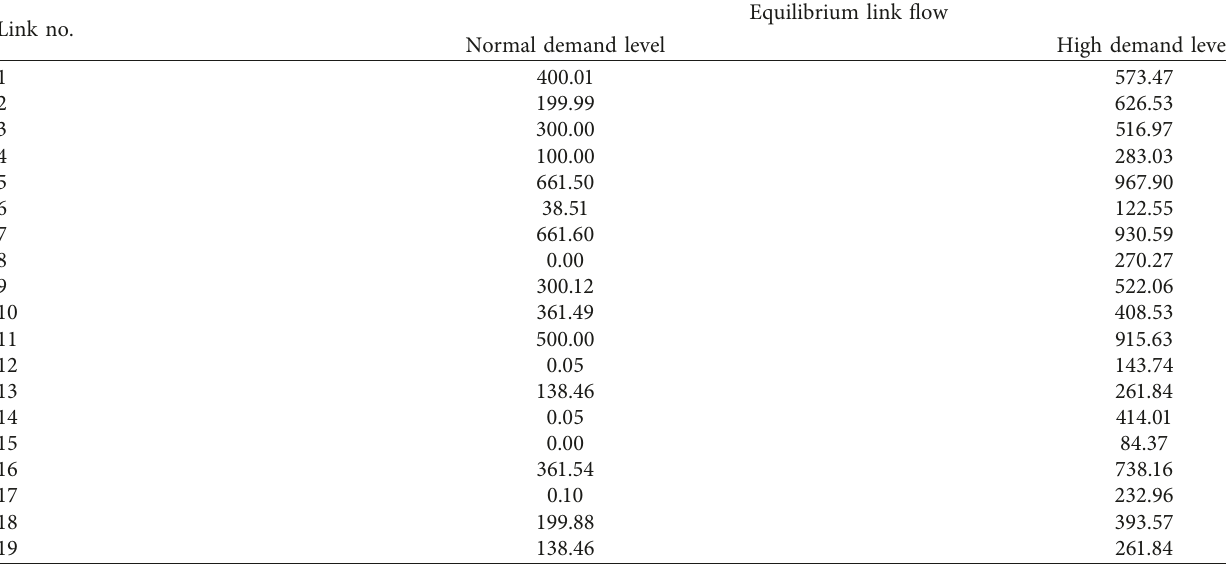
Table 6: Equilibrium solutions under normal condition.